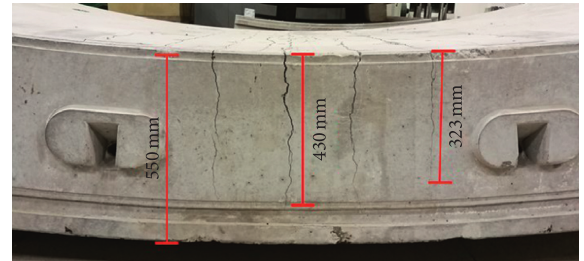
Figure 13: Result of crack development along the thickness